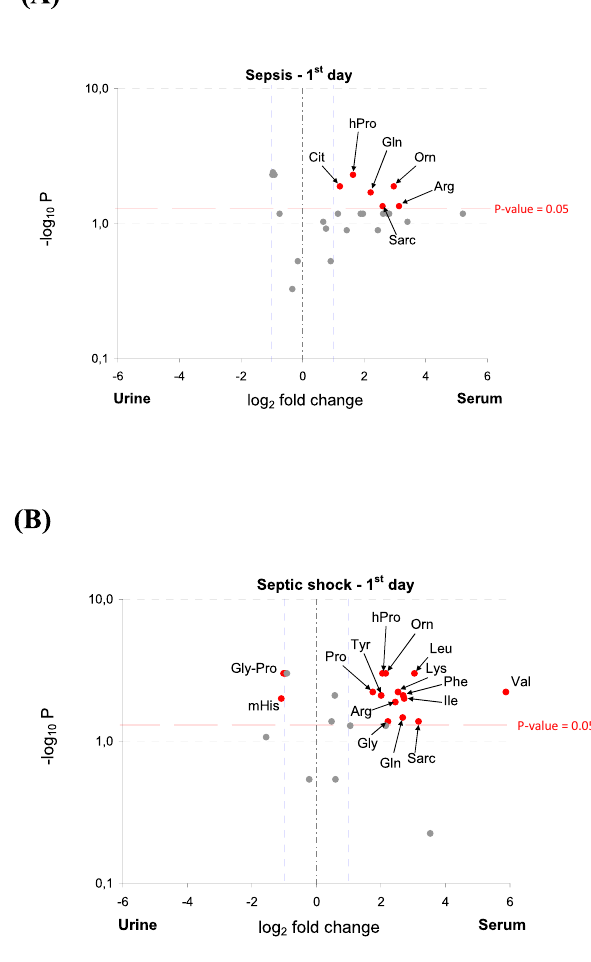
Figure 3. Volcano plot indicating amino acids with the most meaningful changes analyzed in the urine and serum of sepsis ( A ) and septic shock ( B ) on admission based on univariate analysis—y-axis: Mann–Whitney p value, x-axis: fold change (FC). Each dot represents one amino acid. The amino acids with significance p < 0.05 are located above the red horizontal line. The amino acids with more than a twofold change of a concentration are located on right and left from the respective blue right and left vertical lines. Only red dots indicate amino acids with the clinical and statistical differences. Arg, arginine; Cit, citrulline; Gln, glutamine; Gly, glycine; Gly- Pro, glycine-proline; hPro, 4 hydroxyproline; Ile, isoleucine; Leu, leucine; Lys, lysine; mHis, 3-methyl-histidine; Orn, ornithine; Phe, phenylalanine; Pro, proline; Sarc, sarcosine; Tyr, tyrosine; Val, valine; p , significant